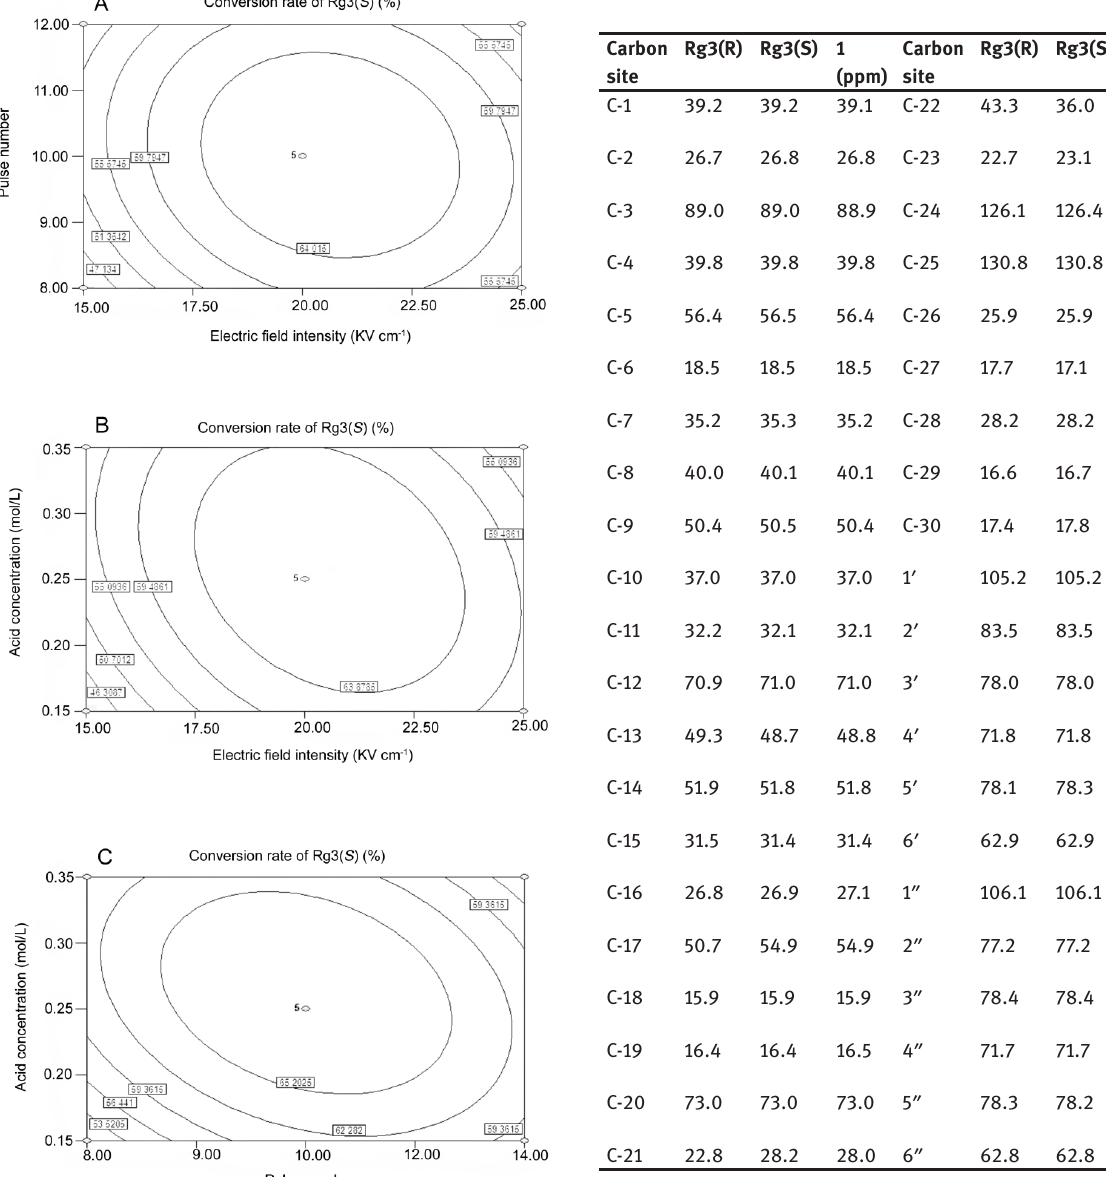
Table 4: 13 C-NMR chemical shifts of ginsenoside Rg3 in pyridine- d